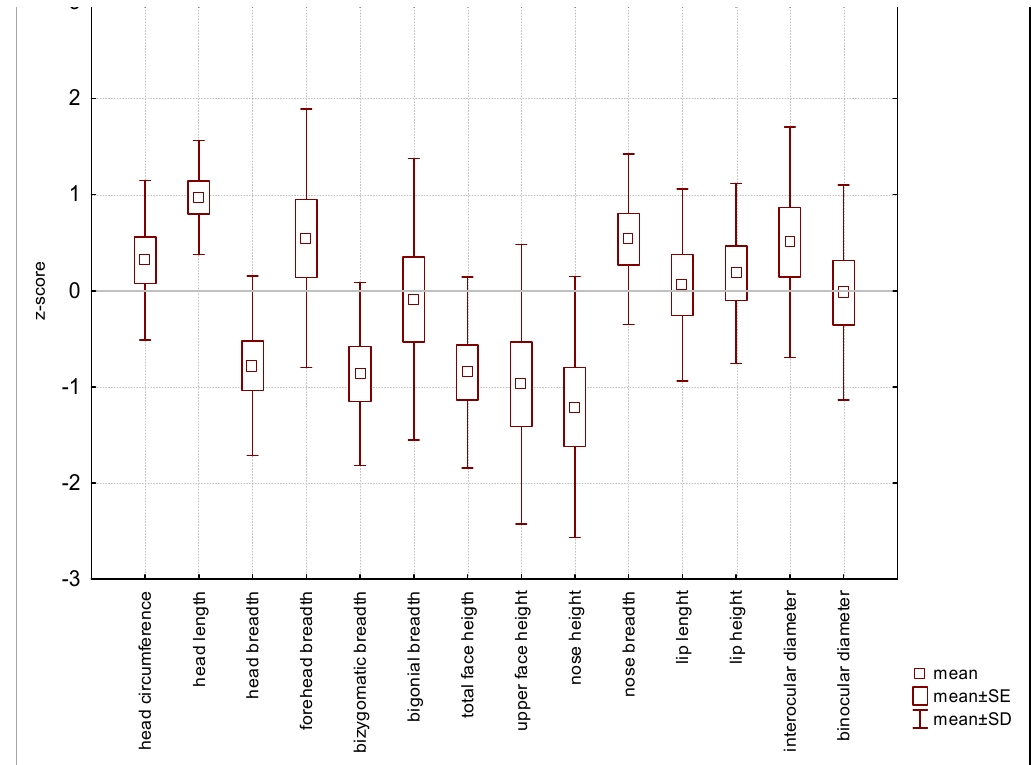
Figure 1. Mean values of somatometric features.